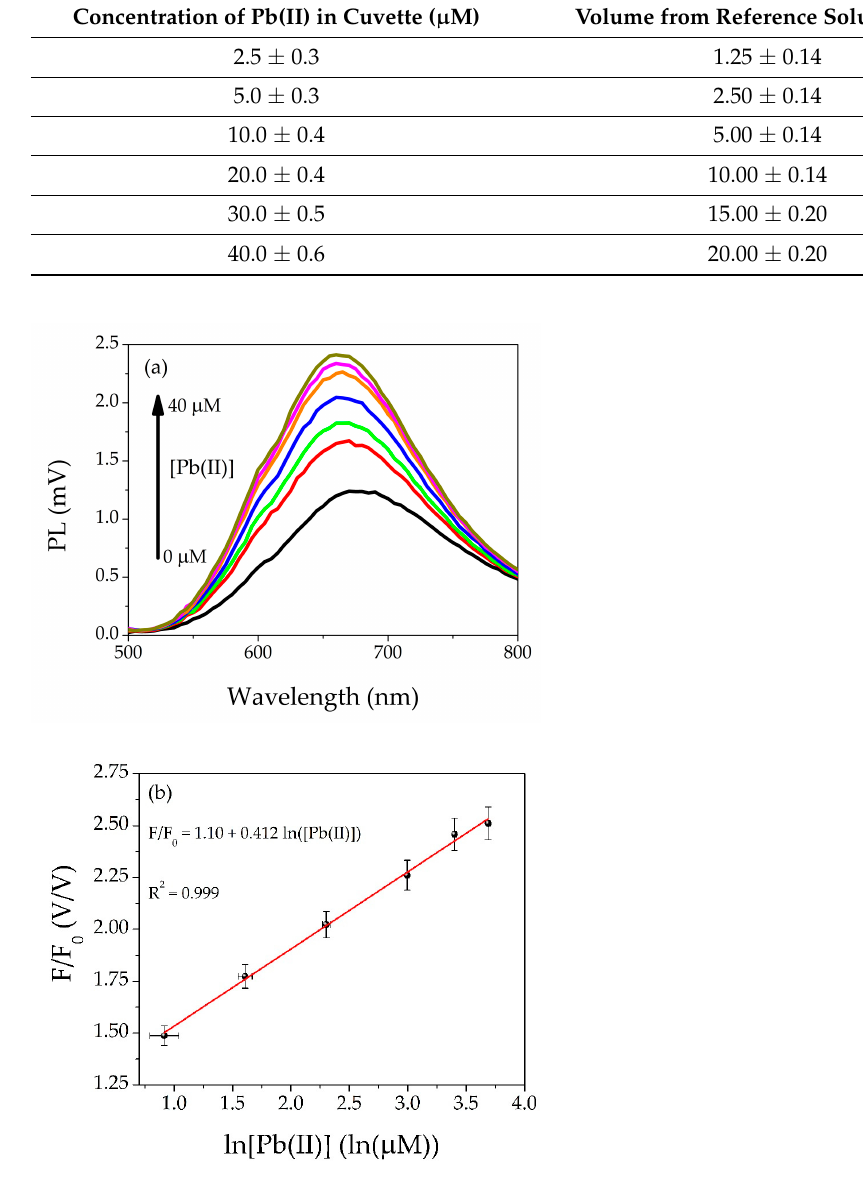
Figure 5. ( a ) Photoemission spectra of AgNCs solution as a function of different concentrations of Pb(II) from 0 to 40 µM; ( b ) an example of linear fit of experimental points.